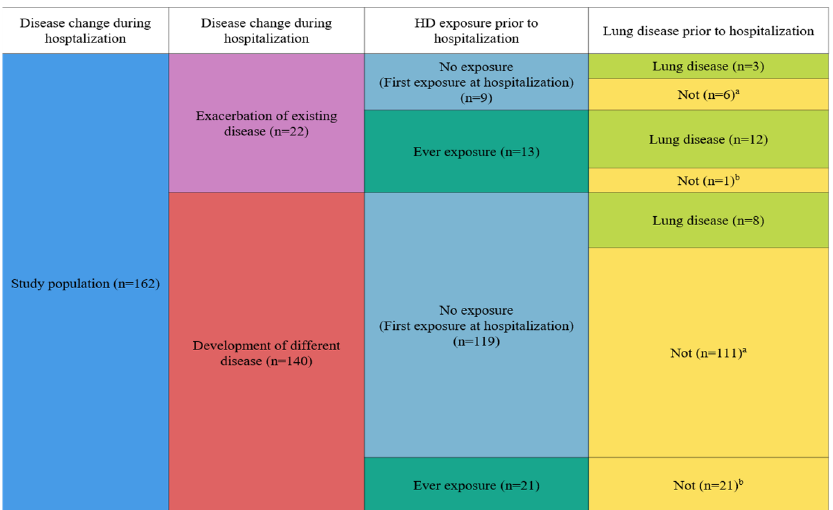
Figure 2. Classification of participants . Subjects number of each group: 128 for no exposure (first exposure at hospitalization) group and 34 for ever-exposure group; 23 for lung disease group and 139 for no lung disease group. a,b Subjects shown in Supplementary Tables S2 and S3.